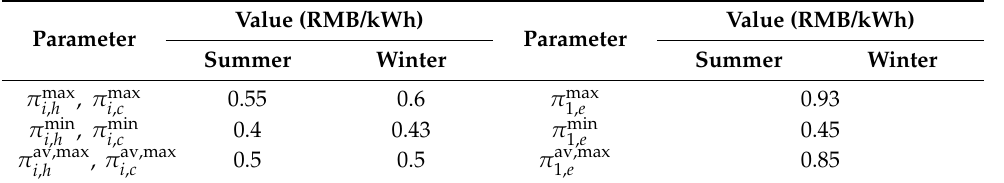
Table A2. The parameters of energy prices.